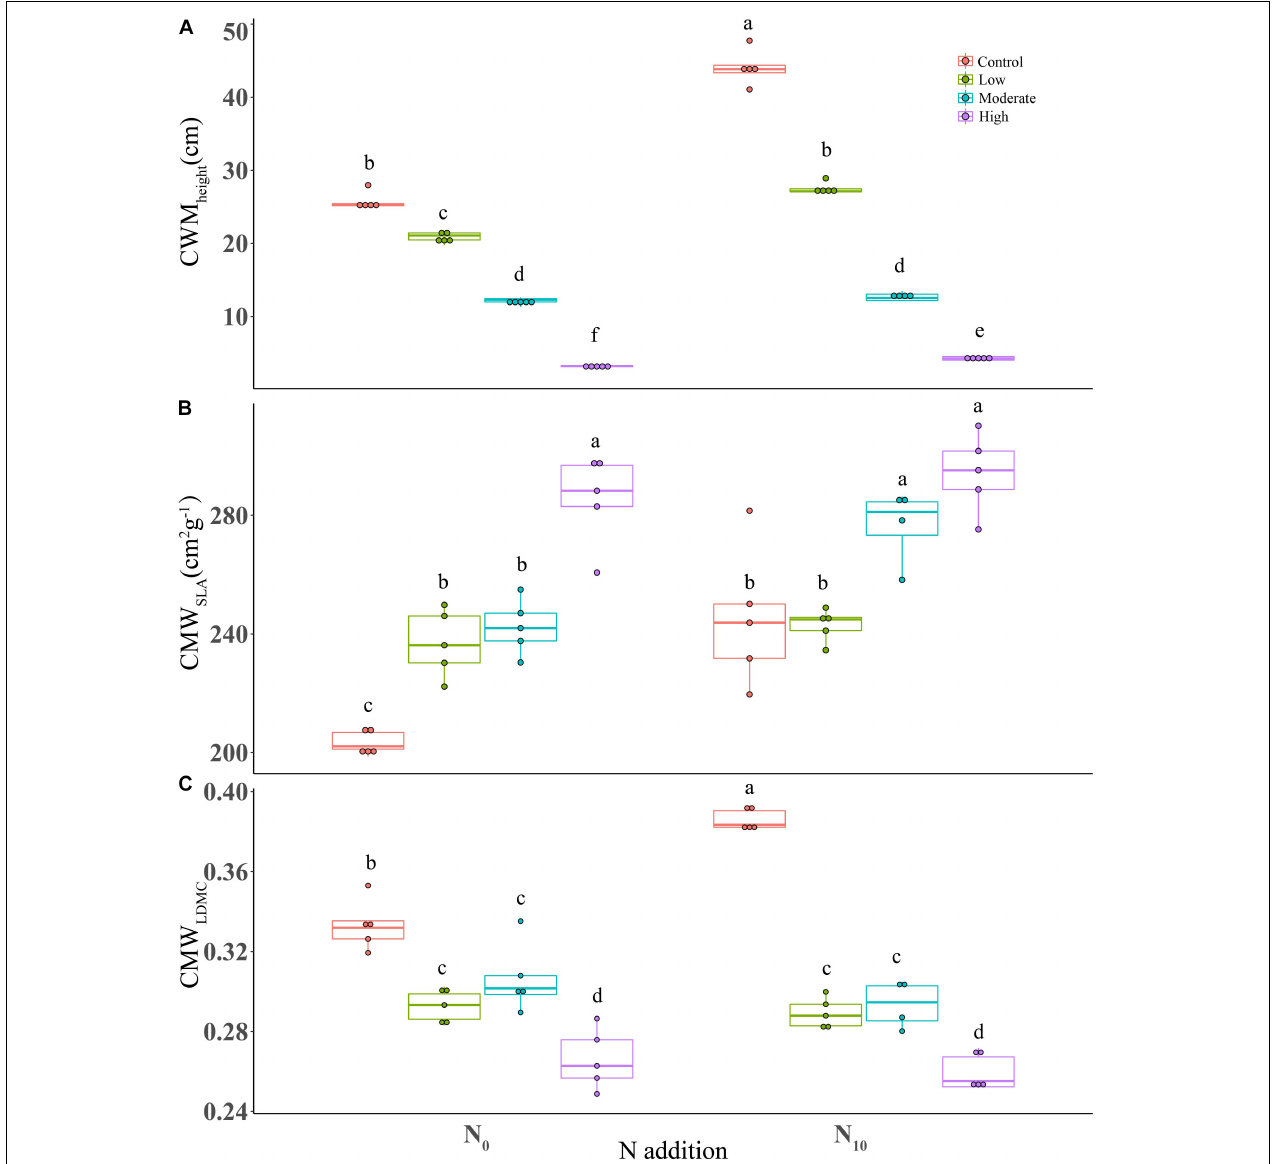
FIGURE 3 | Boxplots showing the differences in CWM of functional traits among fertilization (N 0 : control, N 10 : nitrogen addition) and clipping (i.e., control, low intensity, moderate intensity, high intensity) treatments. (A) height, (B) specific leaf area, and (C) leaf dry matter content. CWM, community weighted mean. The box signifies the upper and lower quartiles, and the whiskers extend up to 1.5 times that intra-quartile range. Median is represented by horizontal line. For a given trait, different letters between treatments donate significant differences ( P < 0.05, Tukey’s HSD